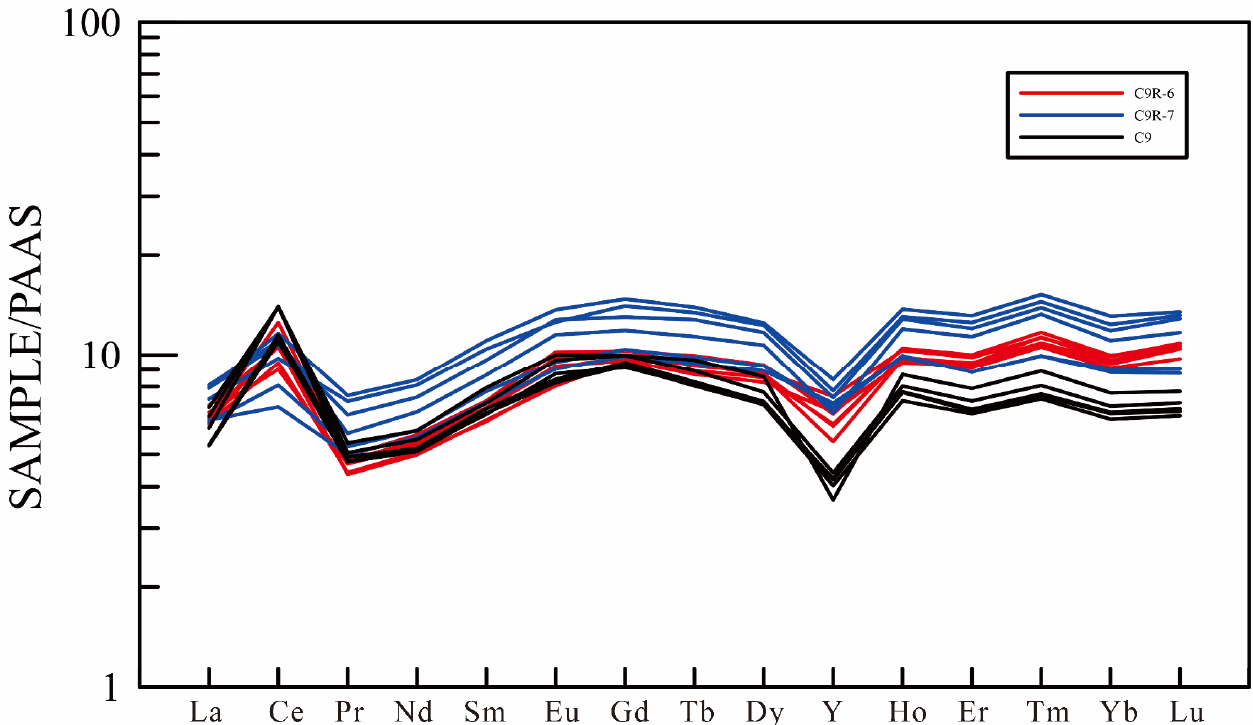
Figure 7. PAAS shale-normalized rare earth element plots for ferromanganese deposits of Caiwei Guyot.